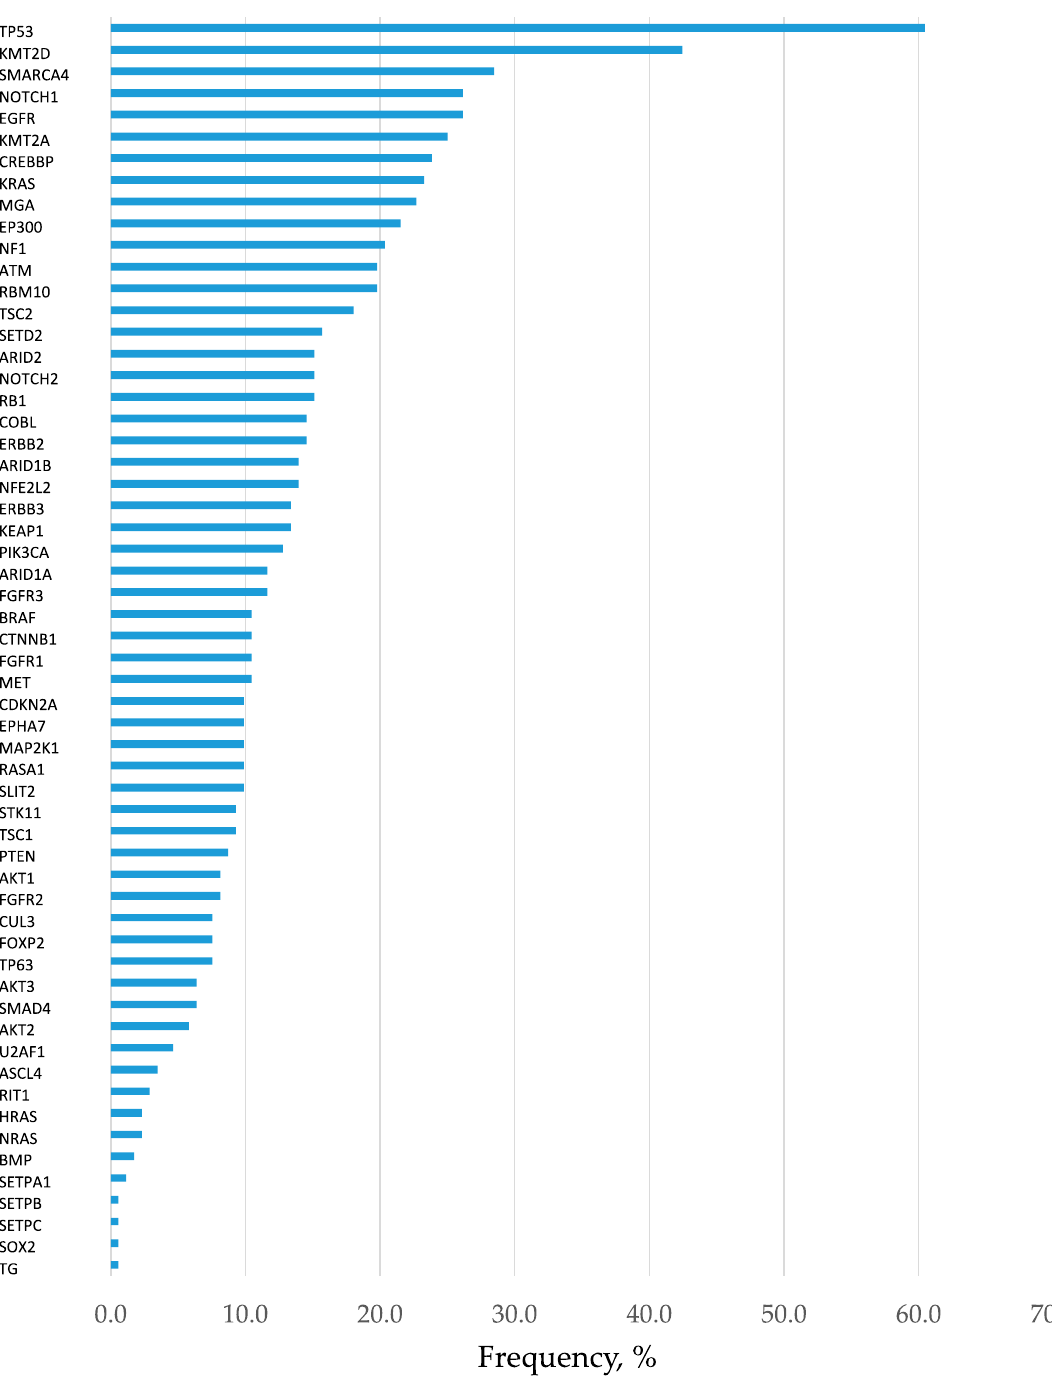
Figure 1. Frequency of detection of gene mutations. Analysis of all 172 patients. All mutations with allele fraction (AF) of > 1% are presented in the order of frequency. Mutations in the tumor protein p53 ( TP53 ) was the most common kind of mutation, present in approximately 60% of lung cancers.